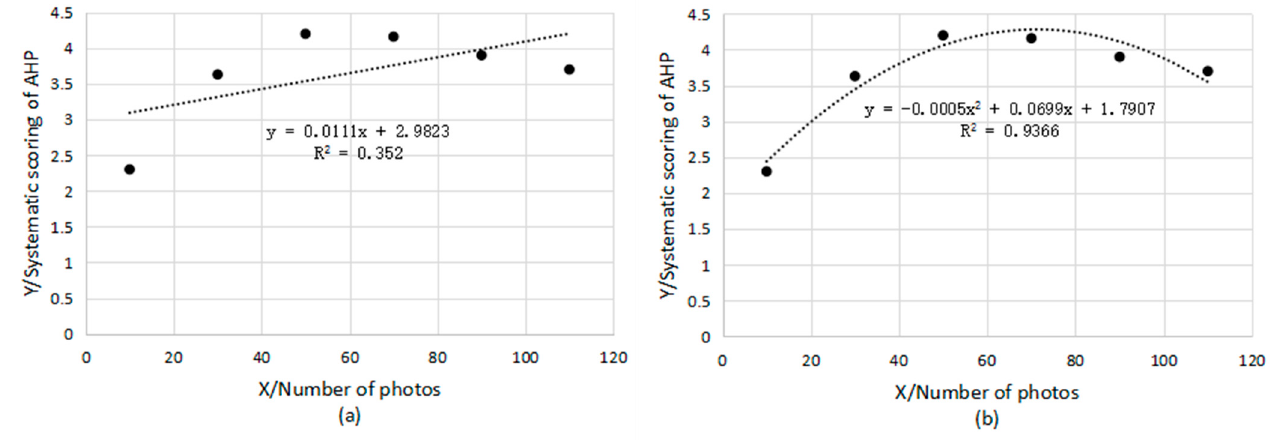
Figure 4. ( a ) Linear fitting function model. ( b ) Quadratic fitting function